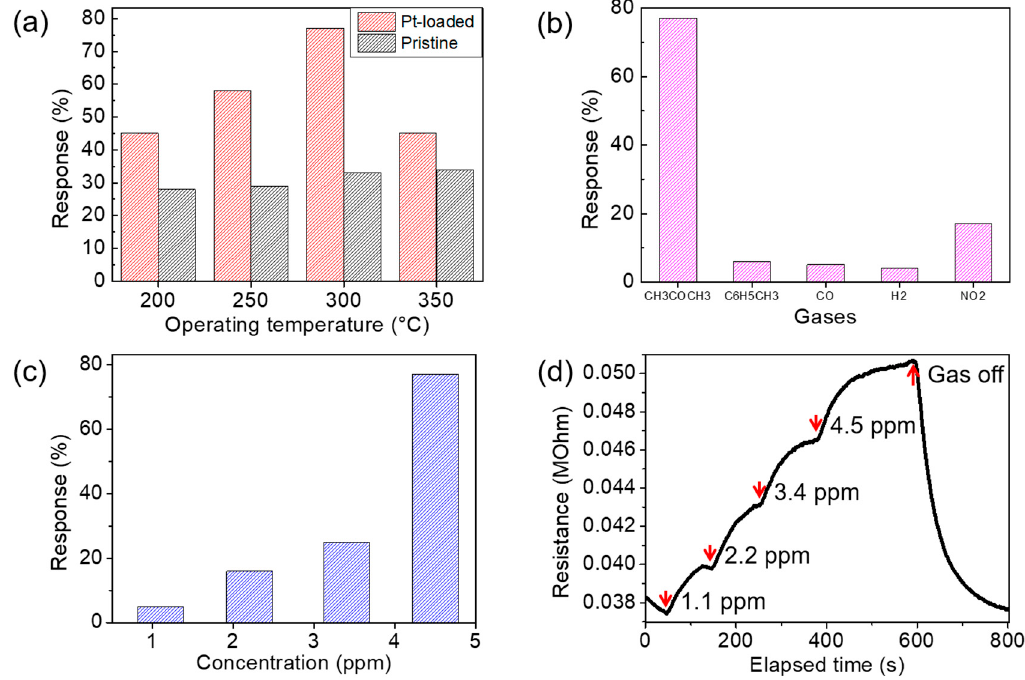
Figure 10. Sensing characteristics of Pt-doped Co(OH) x F 2 − x nanosheet sensors annealed at 350 °C for 2 h. Responses at various operating temperatures compared with a pristine sample toward 4.5 ppm of acetone gas ( a ), toward various gases of 4.5 ppm (CH 3 COCH 3 , C 6 H 5 CH 3 , CO, H 2 , and NO 2 ) at 300 °C ( b ), and toward various acetone concentrations at 300 °C ( c ). ( d ) Dynamic sensing characteristics of the sensor toward an increasing acetone gas concentration at 350 °C.